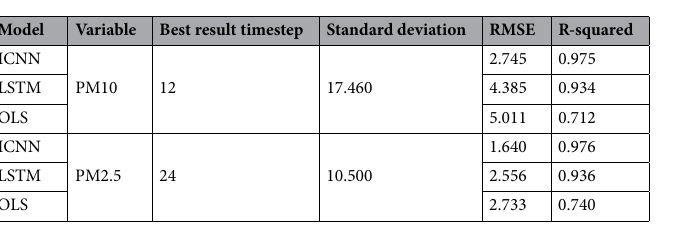
Table 3. RMSE and R-squared values for the one-hour forecast by ICNN and comparative models.